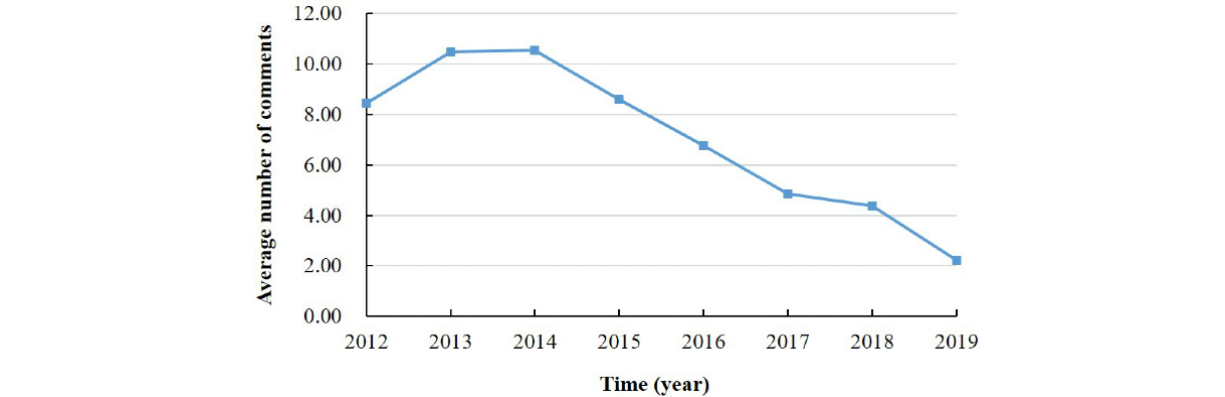
Figure 5. Average number of comments posted in the albinism community each year.